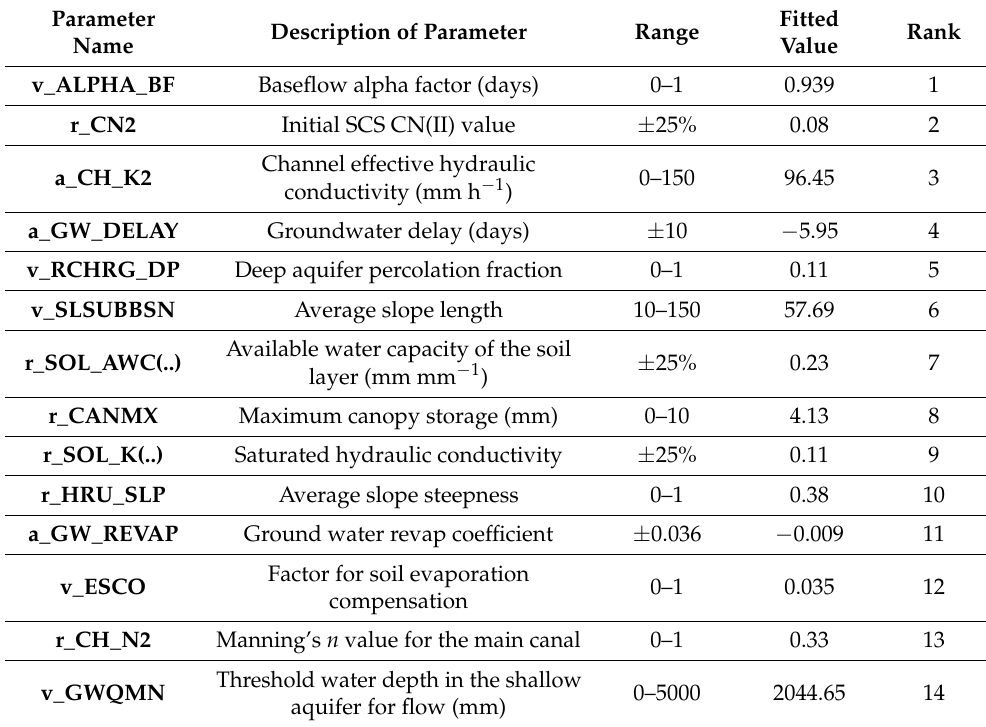
Table 5. List of parameters used to calibrate streamflow, fitted values, parameter ranges, and sensitivity rankings.